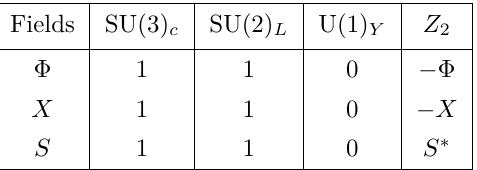
Table 1 . Charges of the new particles under SU(3) c × SU(2) L × U(1) Y × Z 2